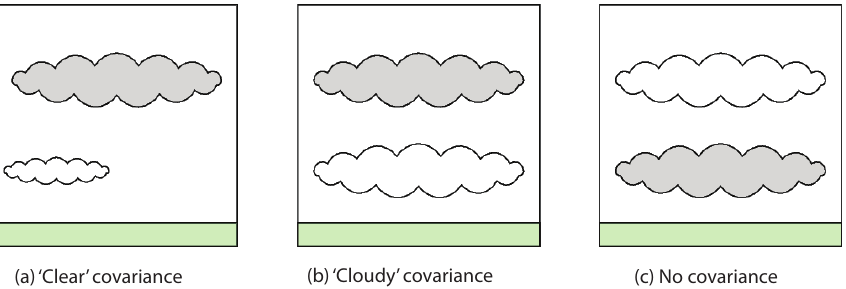
Figure 2. A pictorial form of the assumed scenes for each covariance matrix: (a) a clear-sky scene, or a scene with only a thin layer of cloud beneath the ash plume; (b) a cloudy scene, with a thick cloud below the ash plume; (c) a cloudy scene for which we have no specific covariance, with a thick cloud above the ash